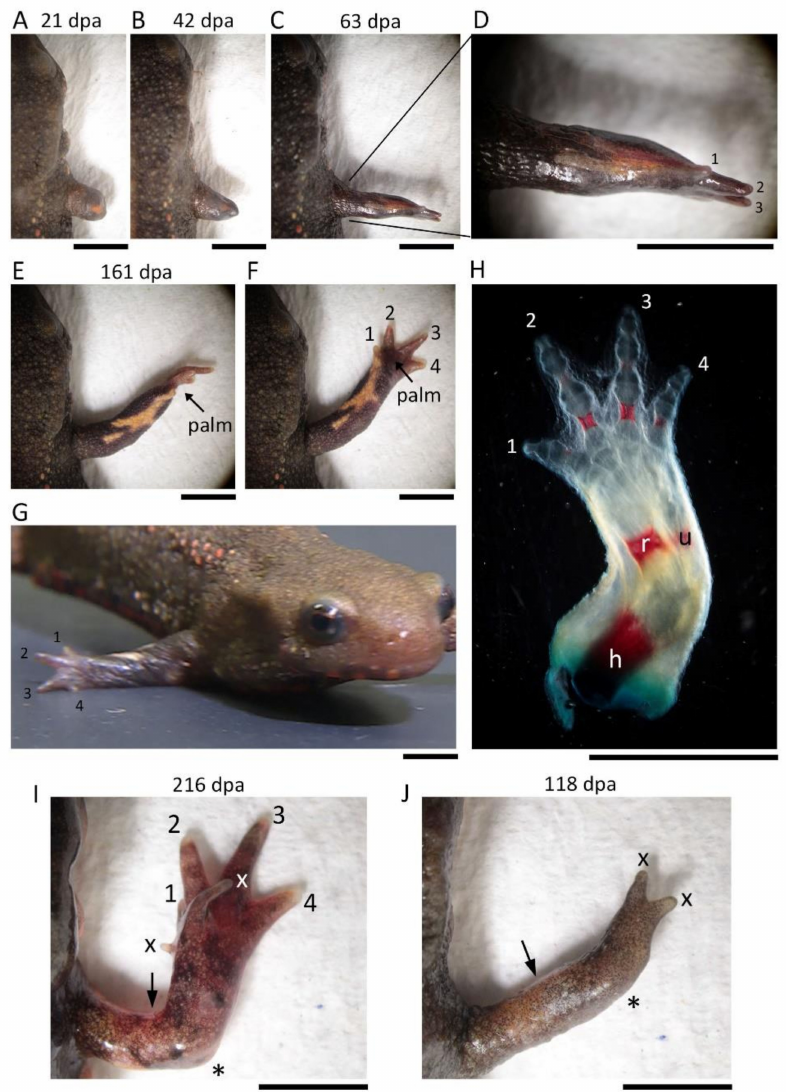
Figure 2. Abnormally regenerated limbs in 180 ◦ skin rotation. ( A – H ) Representative of a limb rotated 90 ◦ forward with a hand in which the order of the digits is reversed (n = 3). ( E – G ) Images of the same animal taken from different angles. ( H ) Skeleton of the regenerated limb shown in ( E ). Hard bone was stained red. ( I ) A limb with a hand with extra digits on the front side of the back of the hand (n = 1). ( J ) A limb with two digits at the top (n = 1). The number near the digit indicates digit number. X indicates the digit whose number could not be determined. The asterisk indicates the elbow. The arrow indicates the amputation position. dpa: day post amputation; u: ulna; r: radius. h: humerus. Scale bars: 5